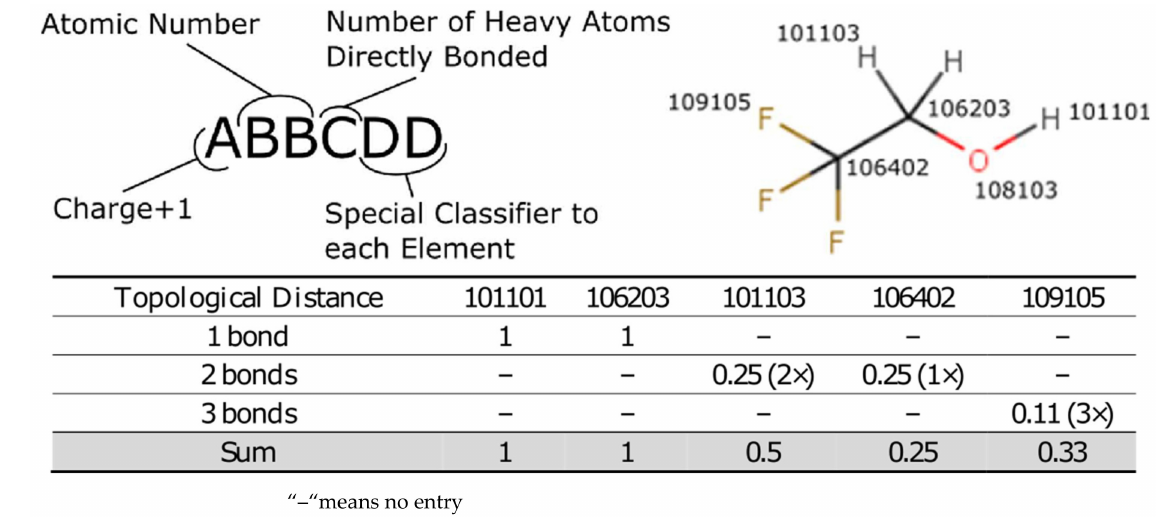
Figure 5. Atom-type description and an example of a distance spectrum calculation. This distance spectrum consists of the sum (one for each atom-type) of the inverse square of the topological distance to the pK a centre, which is the oxygen (ionisation centre). Note that the oxygen (108103) is not included in the calculation of topological distances because it is obviously